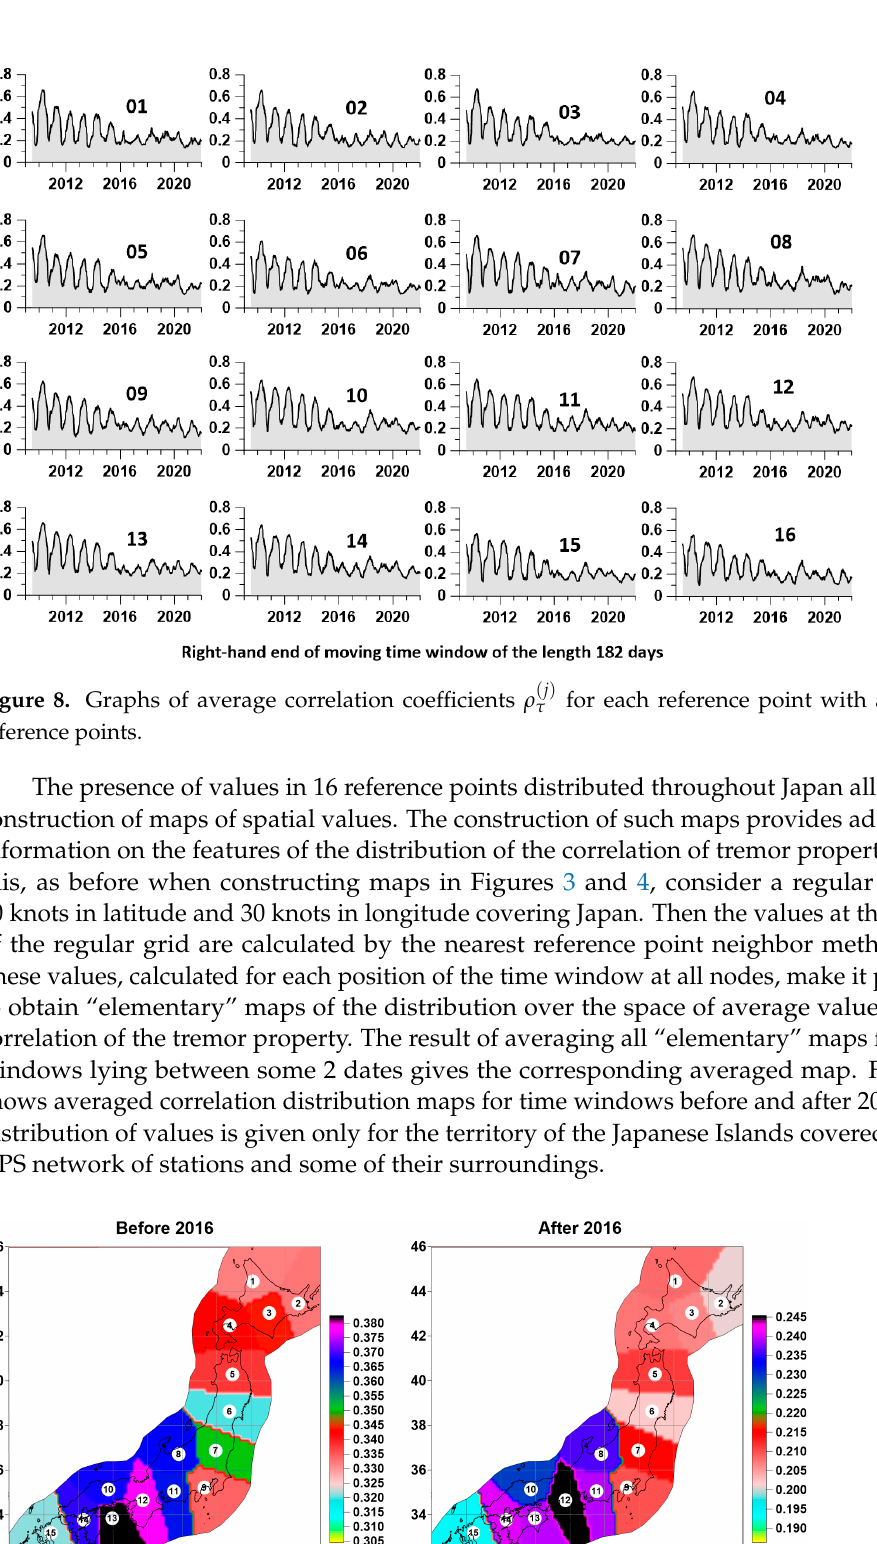
Figure 9. Average maps of interpolation of the distribution of average correlations ( ) j τ ρ from reference points for time windows before and after 2016, obtained by the nearest neighbor method. The numbered white circles represent the positions of the 16 reference points.